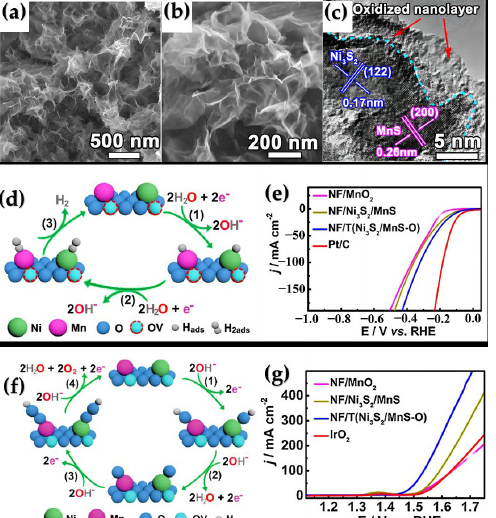
Figure 5. ( a , b ) Scanning electron microscopy (SEM) image and ( c ) High-resolution transmission electron microscopy (HRTEM) image of NF/Ni 3 S 2 /MnS nanosheets. ( d ) Schematics of the HER pathways with Mn and Ni atoms adjacent to OV as active sites. Only one OV near the Mn or Ni atom is illustrated ( e ) HER polarization curve with a scan rate of 10 mV s − 1 at NF/T(Ni 3 S 2 /MnS-O), NF/Ni 3 S 2 /MnS, NF/MnO 2 , and the commercial Pt/C in 1.0 M KOH. ( f ) Schematics of the OER pathways with Mn and Ni atoms adjacent to OV as active sites. Only one OV near Mn or Ni atom is illustrated. ( g ) OER polarization curve with a scan rate at 10 mV s − 1 of NF/T(Ni 3 S 2 /MnS-O), NF/Ni 3 S 2 /MnS, NF/MnO 2 , and commercial IrO 2 in 1.0 M KOH. Reproduced with permission from